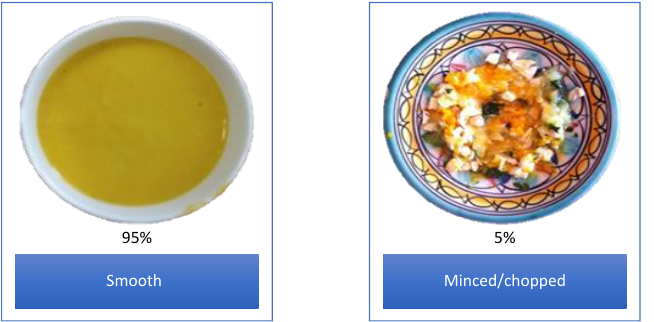
Figure 2. Examples of the HMFs for texture classification. Pictures were taken by the mothers included in this study.